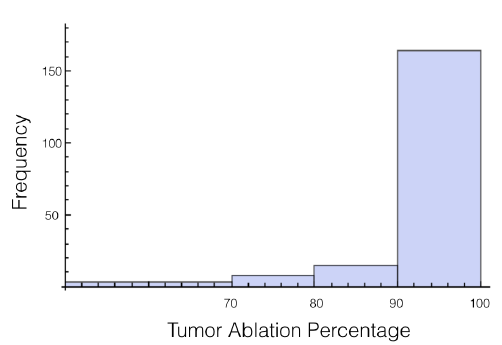
Figure 8. Histogram for percentage of tumor above 700 V/cm for case 3 at 2000 V.